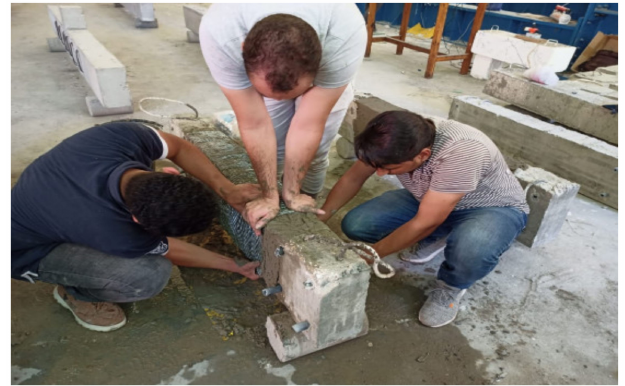
Figure 5. Beam B4-1SM.